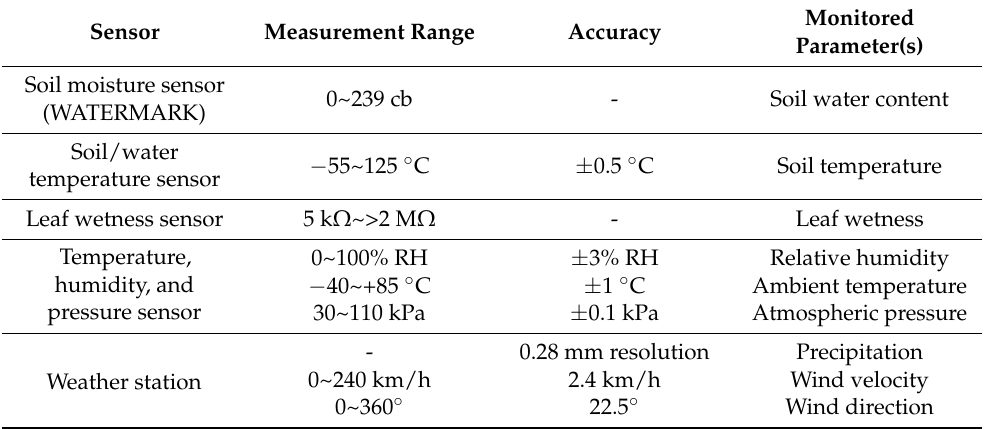
Table 1. Sensors, their characteristics, and attributes measured by the developed